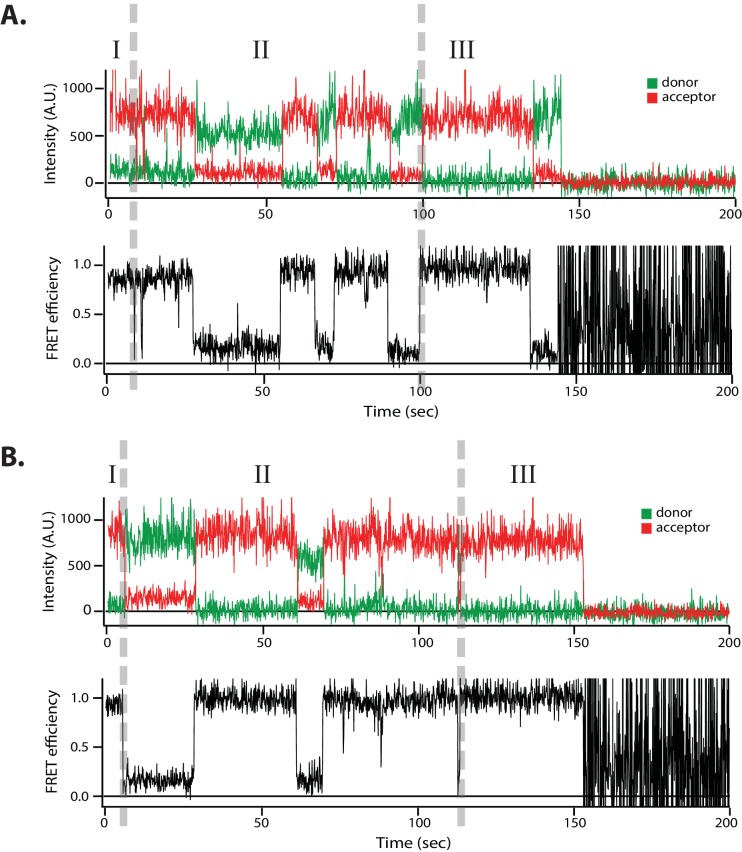
Representative smFRET efficiency time traces of L-SNARE-CC.Single-molecule fluorescence time traces were converted to FRET efficiency time traces and divided into three sections (I, II, III) (Materials and methods). Only section II was used for data analysis.